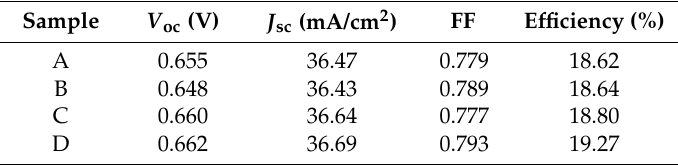
Table 1. The detailed electrical external parameters for all PERCs (passivated emitter and rear